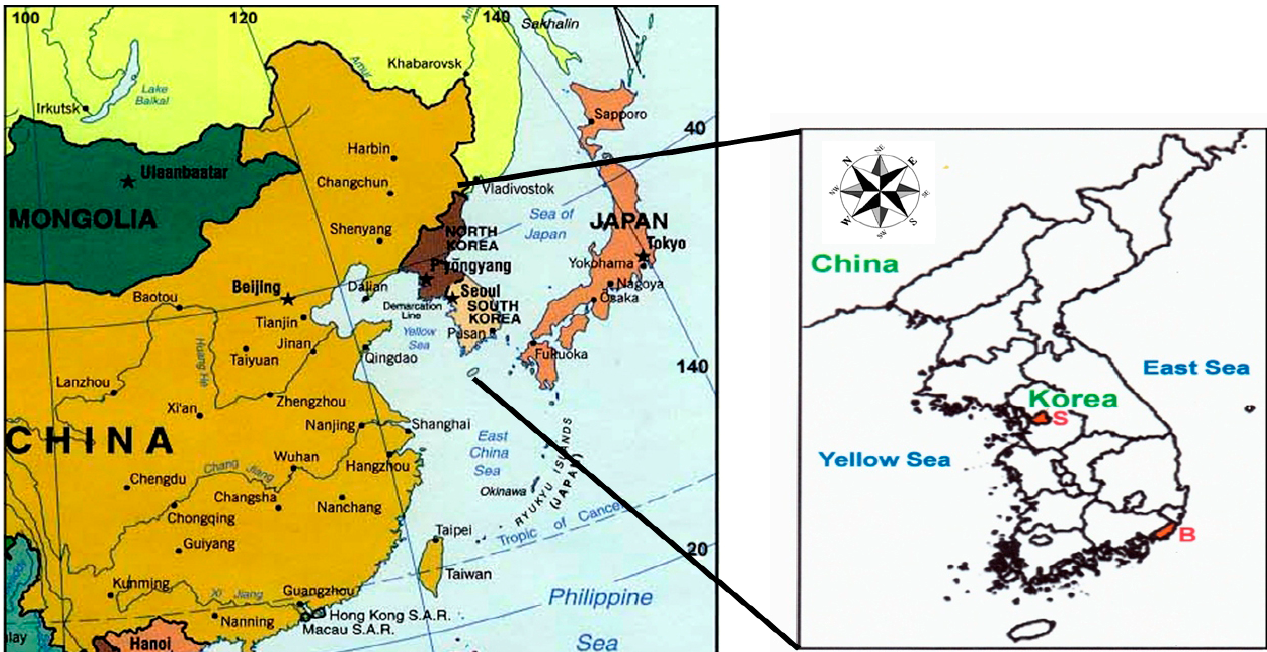
Figure 1. Location of two megacities, Seoul and Busan (colorful districts) on the left of S, and B which are connected with the busiest highway of about 430km in South Korea.